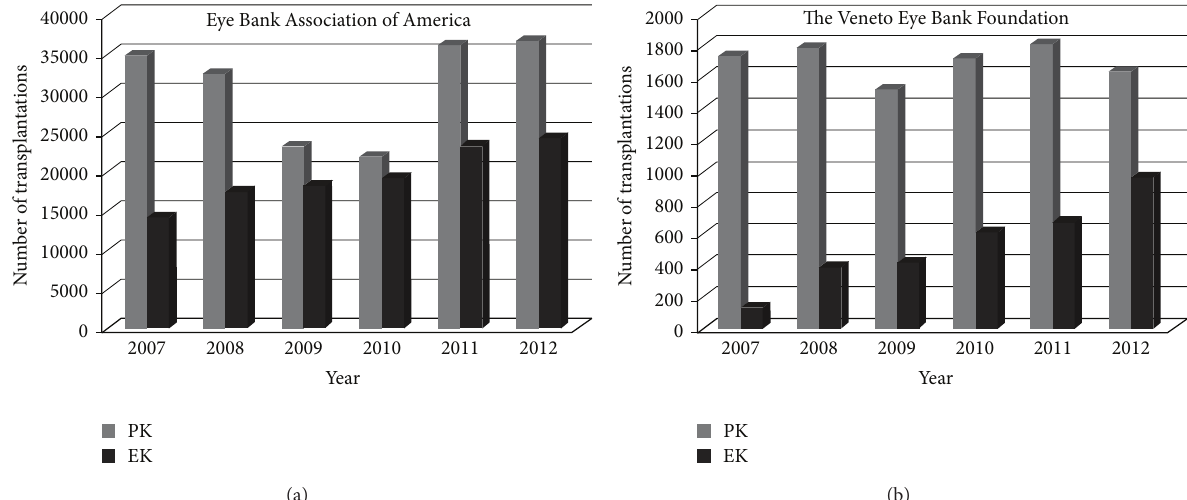
Figure 2: The data shows the increasing number of EK transplants per year in the (a) United States of America (eye banking statistical report, Eye Bank Association of America, 2012) and at (b) the Veneto Eye Bank Foundation, Italy (2012 annual statistical report of donation and